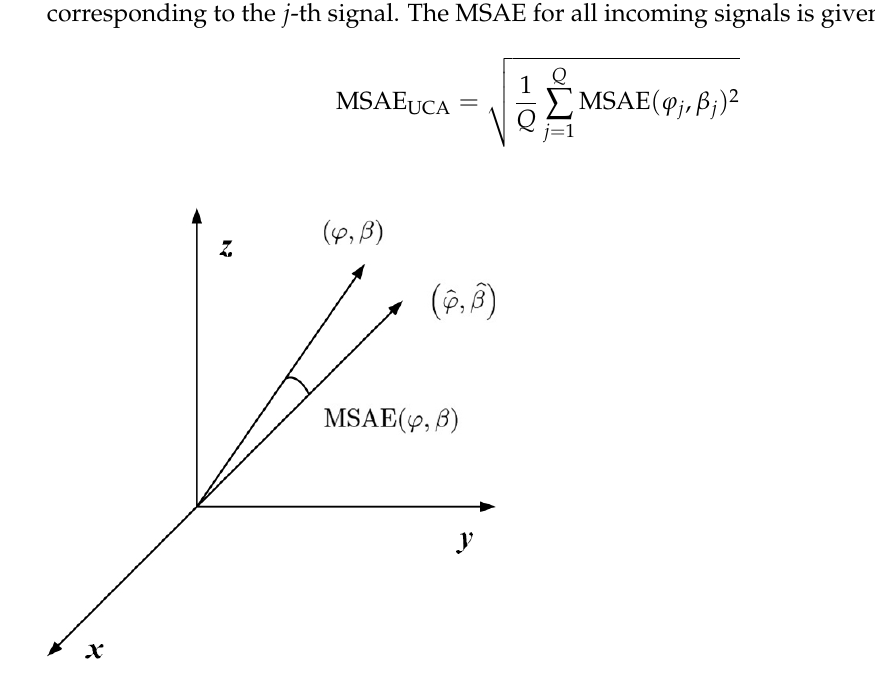
Figure 12. The illustration of the MSAE for 3-D DOA estimation.